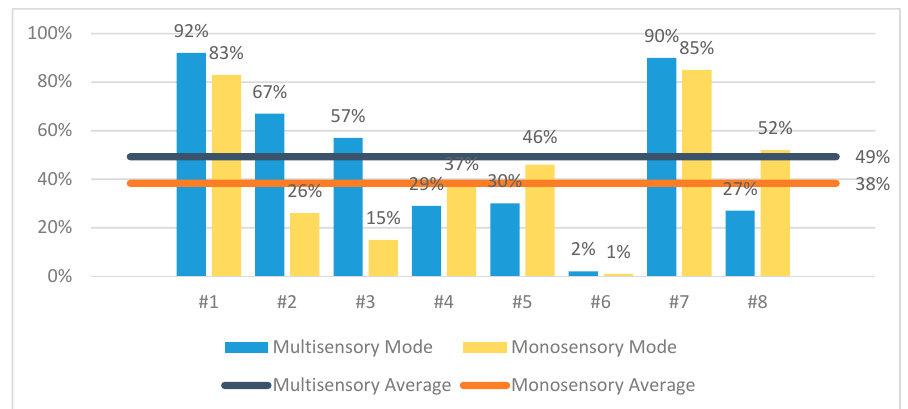
Figure 8. How participants felt after each session ο f the CaLmi evaluation.